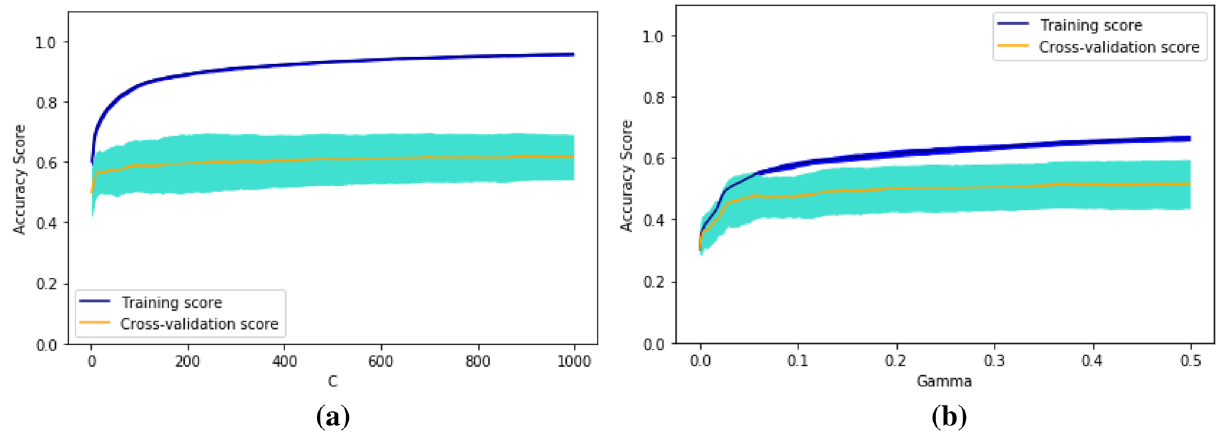
Fig. 8 Validation curves for RF classifier to identify stable search range for four primary model parameters. a Number of estimators, b maxi- mum depth of tree, c minimum samples required for splitting the internal node. d Minimum samples required at the leaf node